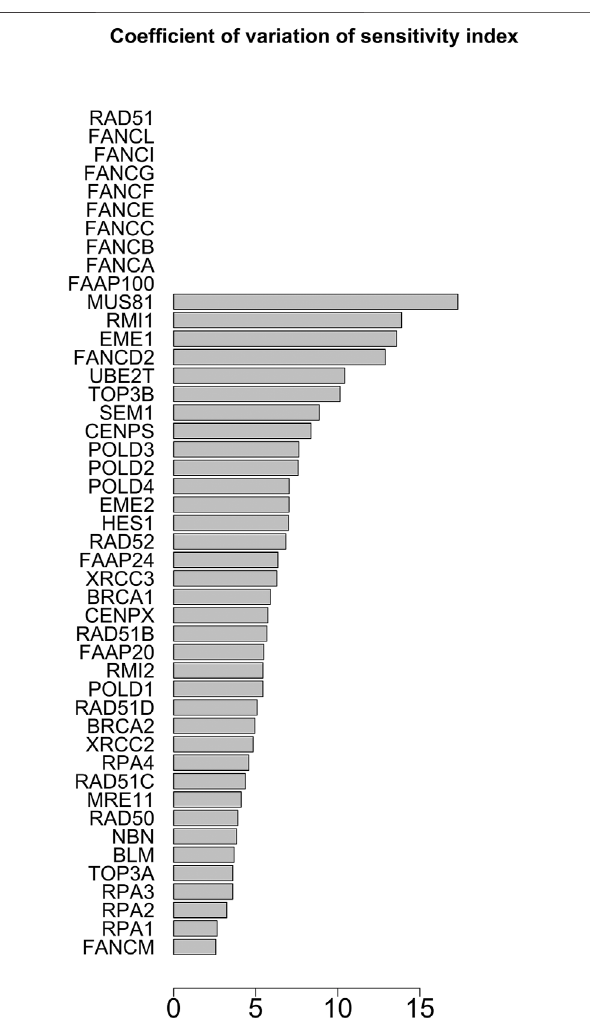
FIGURE 11 | Coef fi cient of variation of the sensitivity index distributions for the proteins in HR network (Orlic-Milacic, 2015) merged with FANCM pathway (Pathways Commons, 2022). These results refer to simulation in the time interval [18, 20] a.u., and initial values of the proteins randomly sampled in the range [10 – 5 , 10 – 6 ] a. u.